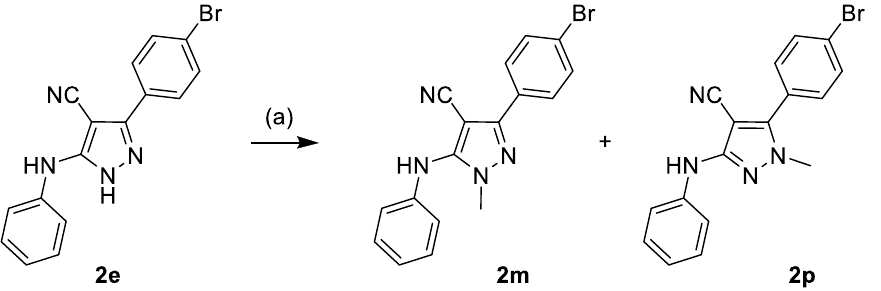
Figure 2. General structure of previously synthesized pyrazoles 1 and 2. The 3-phenyl and the 5- anilino- substituents are colored red and blue,